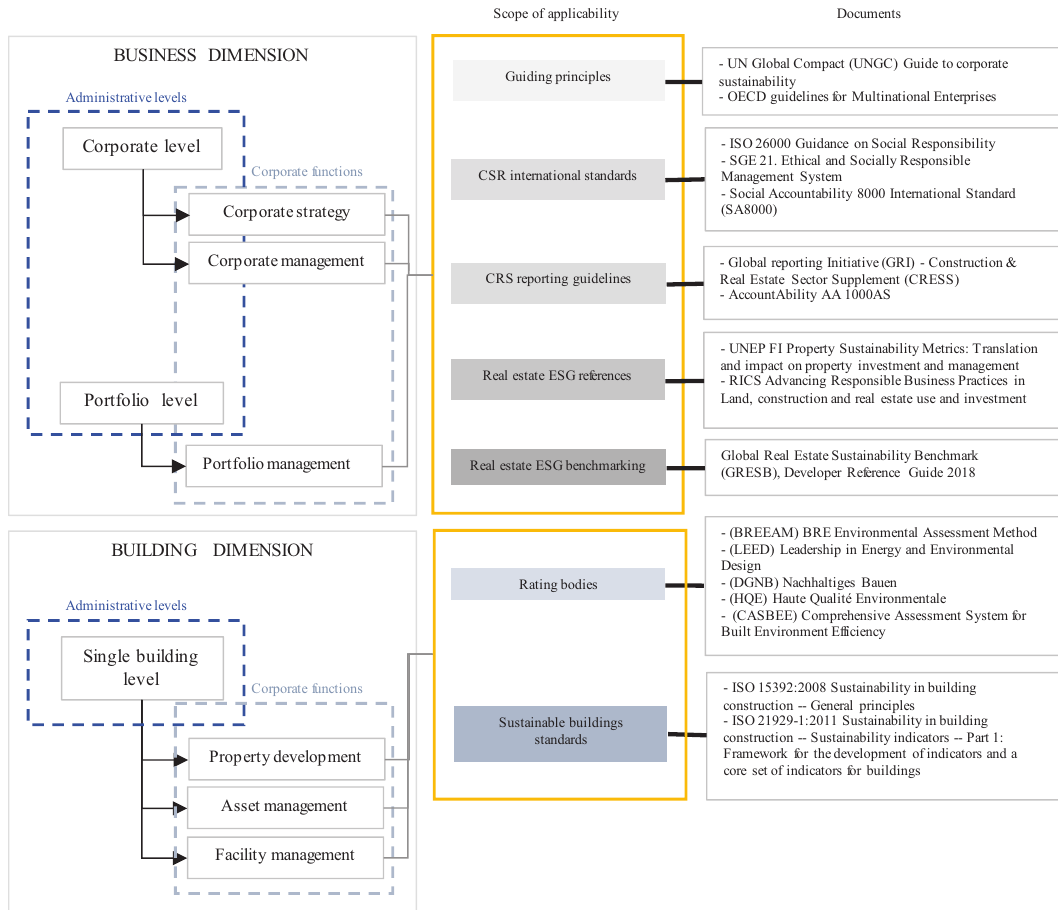
Figure 1. The connection between the administrative levels, corporate functions and the classification of the main documents used by each level (source: elaborated by the